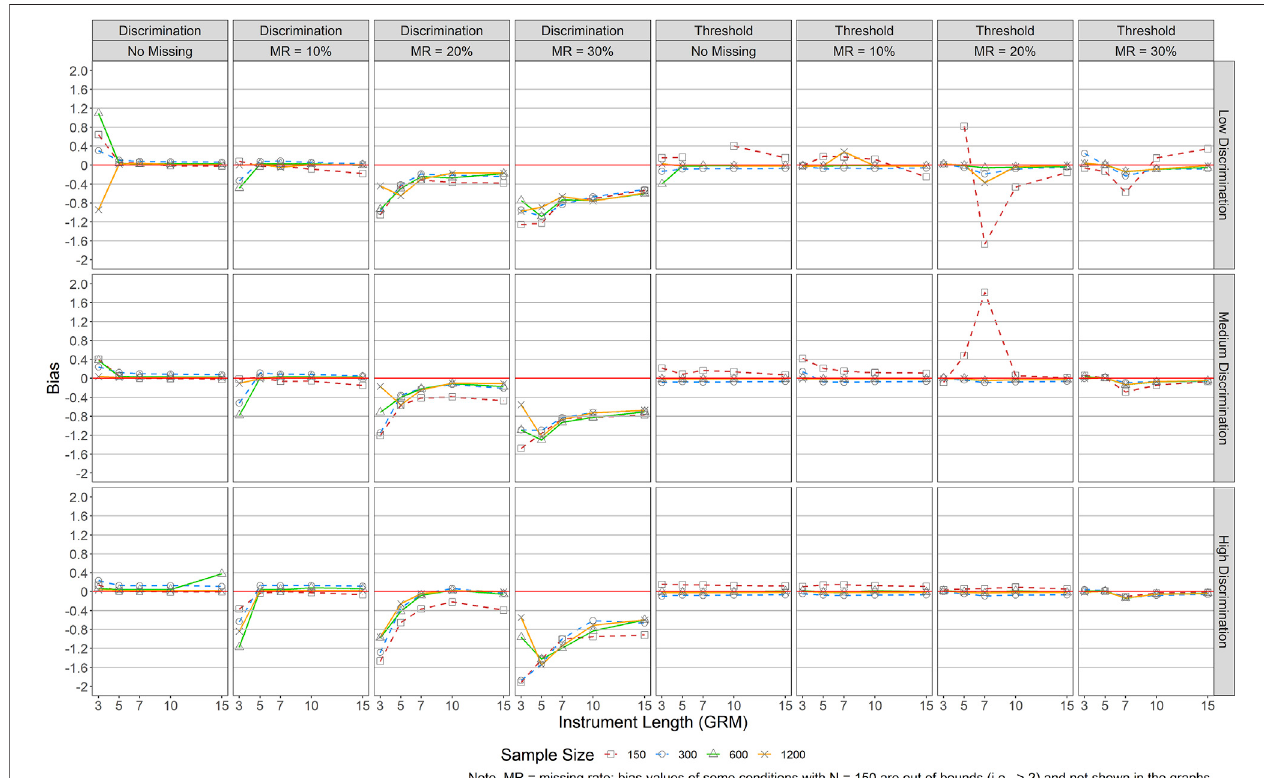
FIGURE 2| Bias ofItem Parameter Estimations for GRM. Note. MR (cid:1) missing rate; bias values ofsome conditions with N (cid:1) 150 are out of bounds (i.e., > 2) and not shown in the